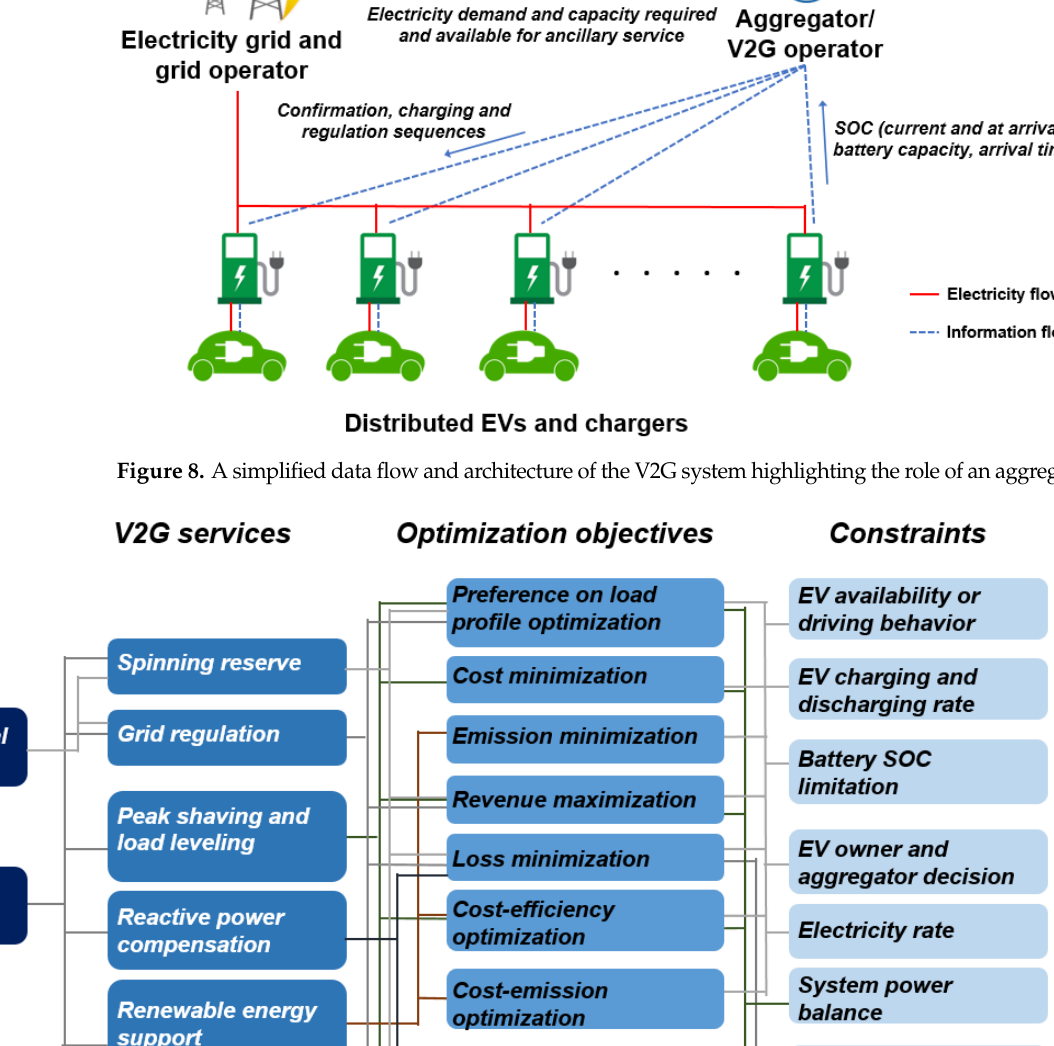
Figure 8. A simplified data flow and architecture of the V2G system highlighting the role of an aggregator.